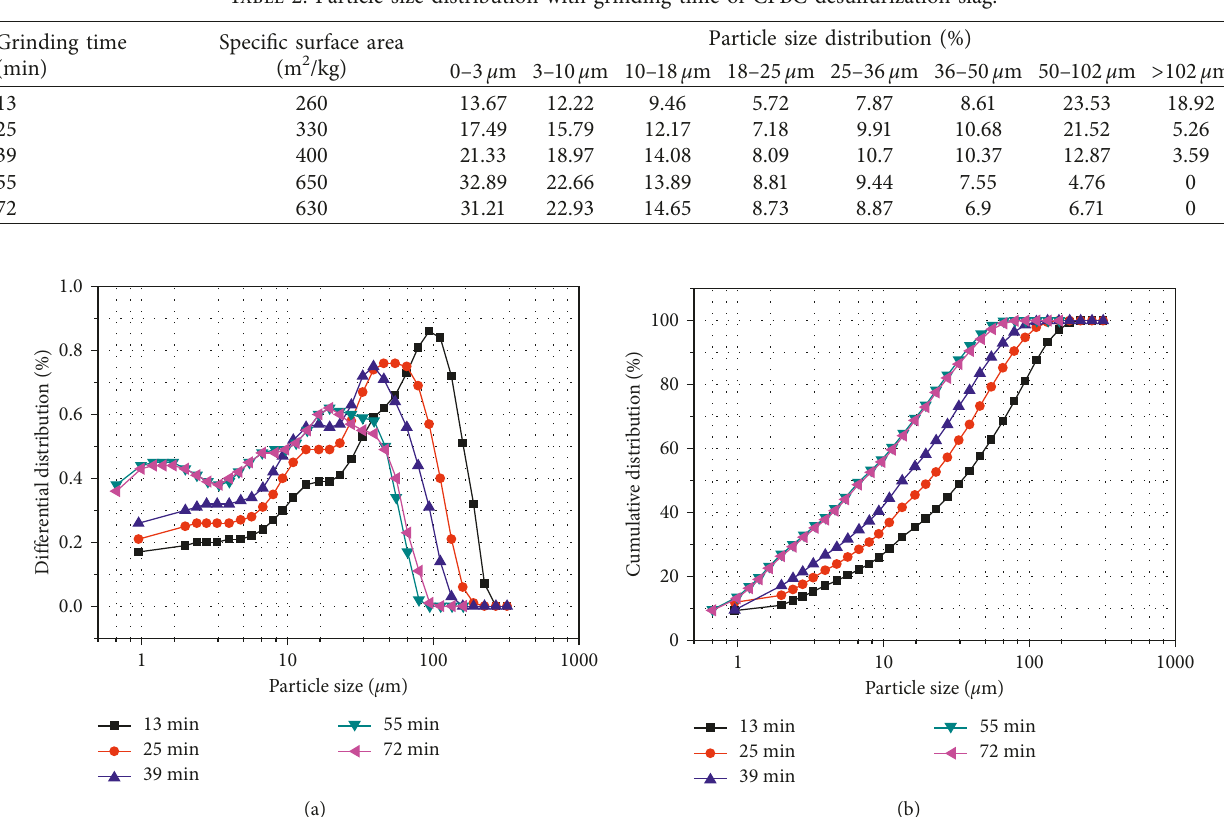
Table 2: Particle size distribution with grinding time of CFBC desulfurization slag.